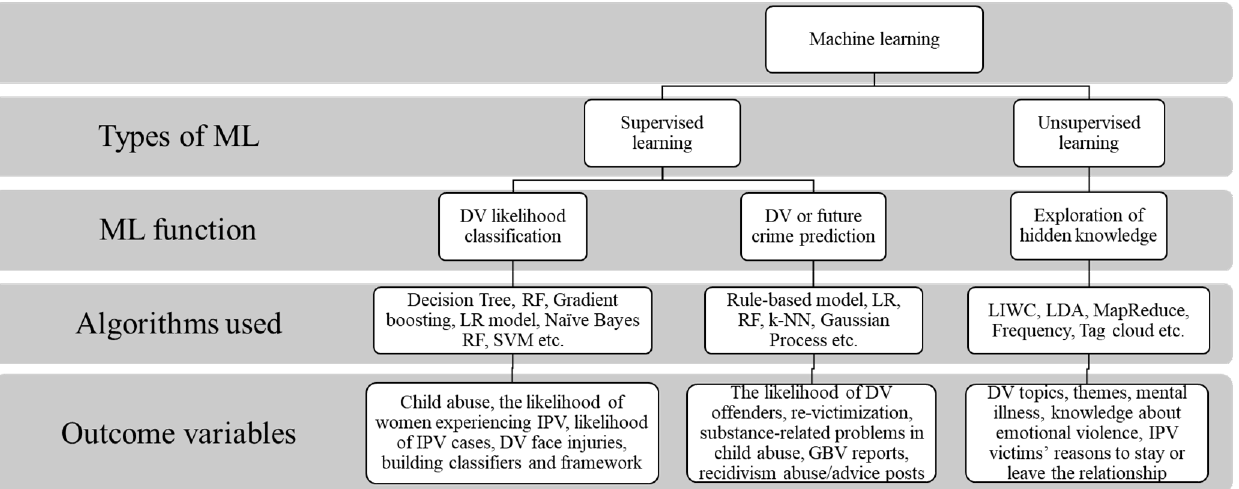
Figure 2. Technicalities of ML application in DV research. Note: SVM: Supper vector machine, RF: Random forest, LR: Linear regression, LDA: Latent Dirichlet Allocation, CNNs: Convolutional neural network, RNNs: Recurrent neural network, LIWC: Linguistic Inquiry Work Count, k-NN: k-nearest neighbors.